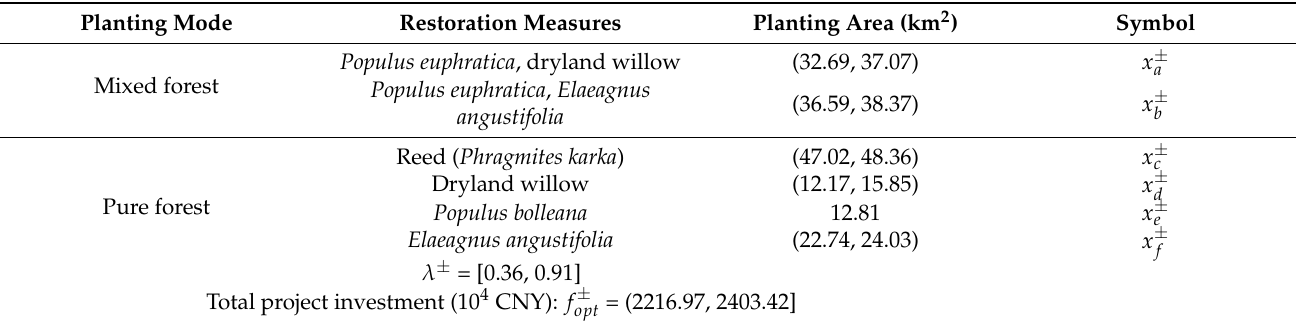
Table 4. Optimal solutions for allocation pattern of restoration measures obtained from the IFLP